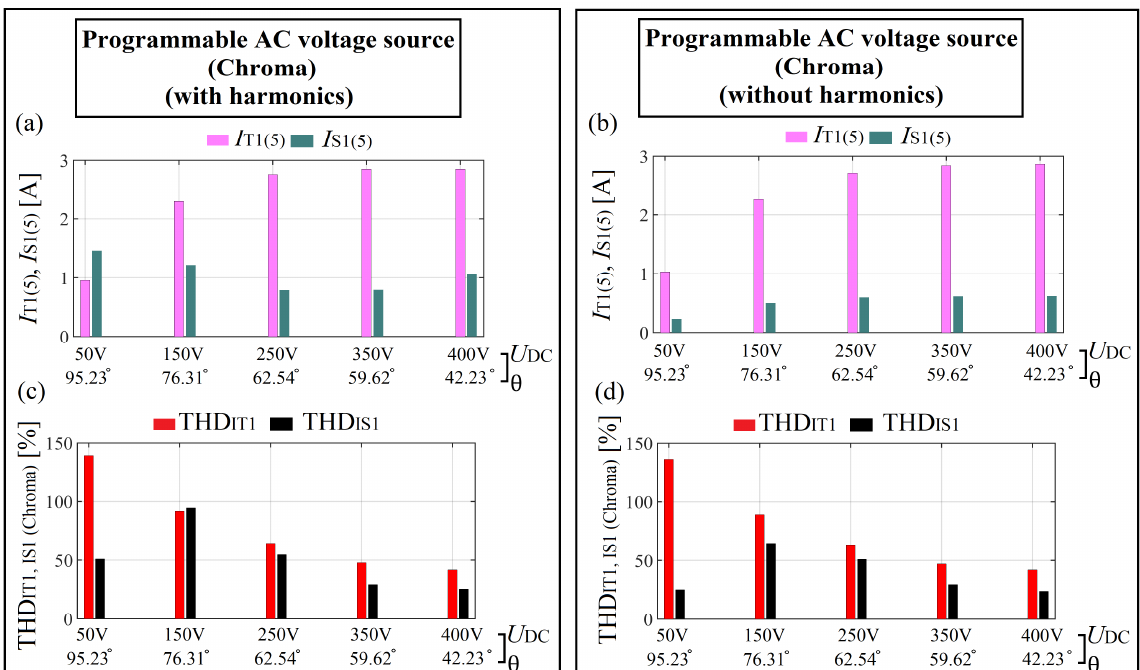
Figure 37. The amplitude ( a , b ) of the 5th harmonic current, as well as the current THD ( c , d ) measured at the load input, are compared to the ones measured at the Chroma voltage source input. The line reactor L SS is considered.